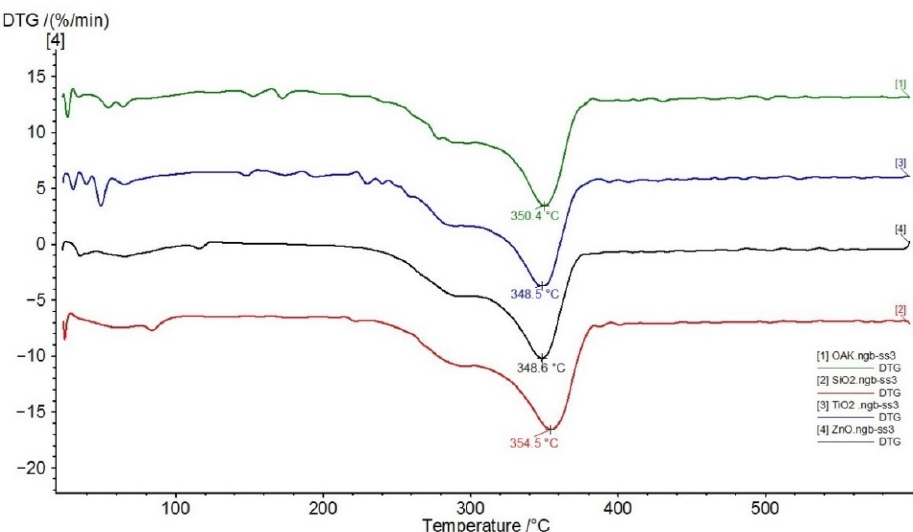
Figure 1. Differential thermal gravimetry (DTG) curves of the samples treated with 3% dispersion of nanoparticles (1—Oak wood, green; 2—SiO 2 , red; 3—TiO 2 , blue; 4—ZnO, black).